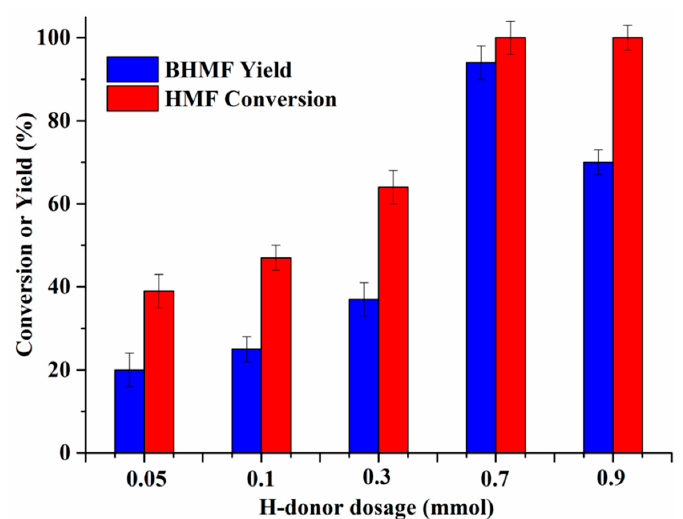
Figure 4. Effect of H − dosage of Ph 2 SiH 2 on the reduction of HMF into BHMF. (Reaction conditions: HMF (0.5 mmol), K 2 CO 3 (0.1 mmol), MTHF (2 mL), 25 °C, and 2 h; After the reaction, 3 mL methanol